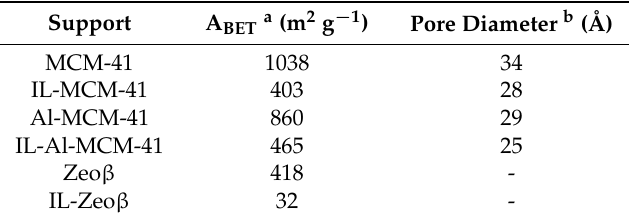
Table 2. Structural properties of the synthesized materials.